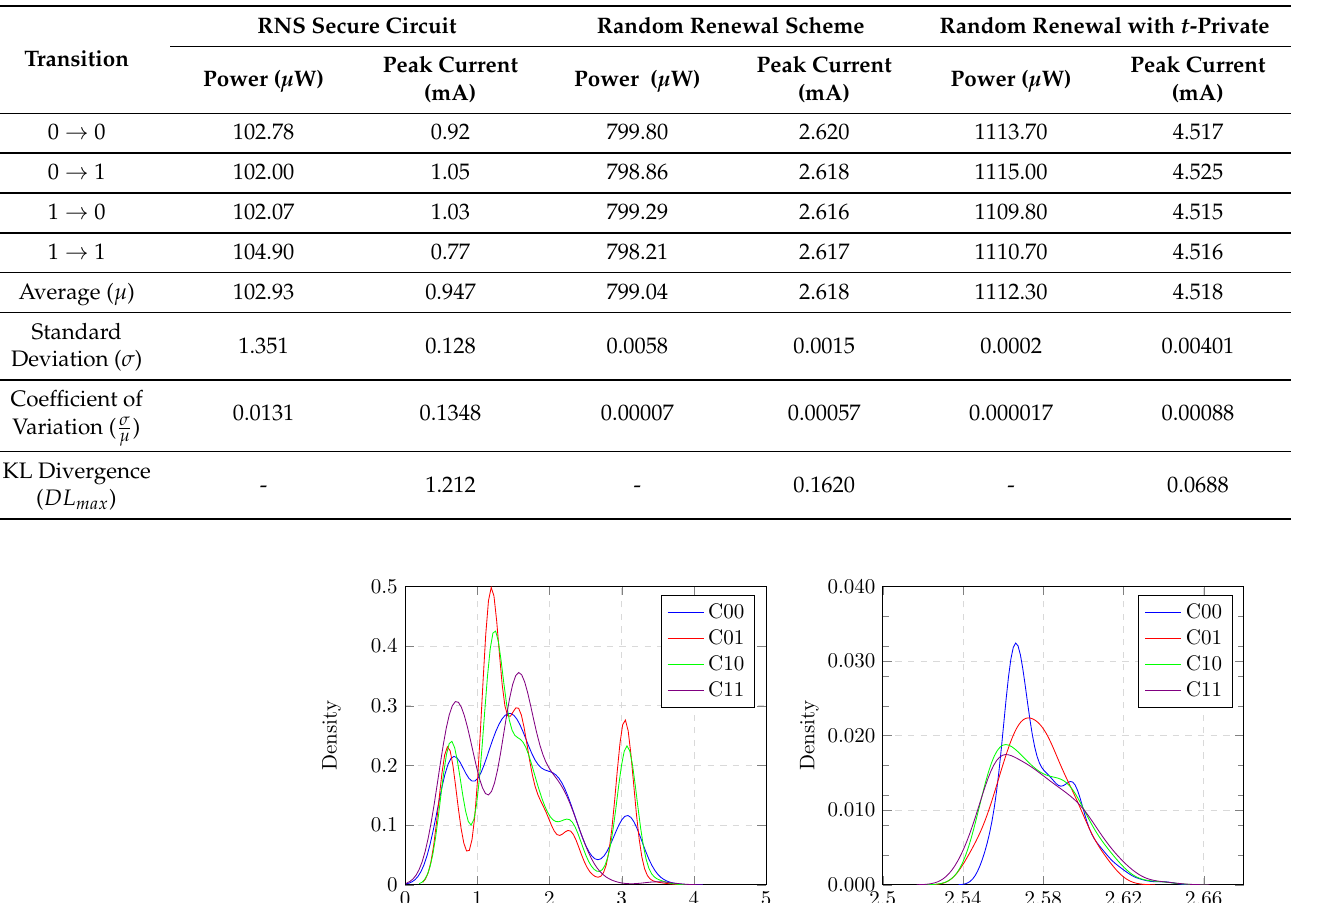
Table 4. SCA Metrics for various RNS schemes with separate random values.